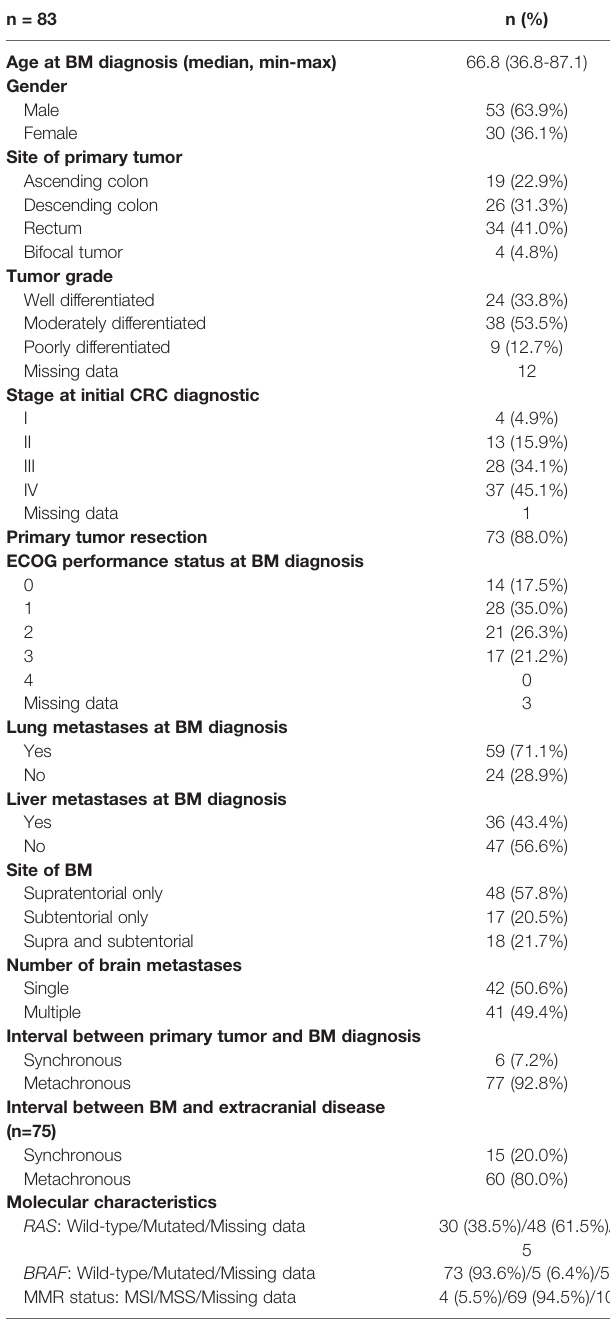
TABLE 1 | Patients, primary tumors and brain metastases